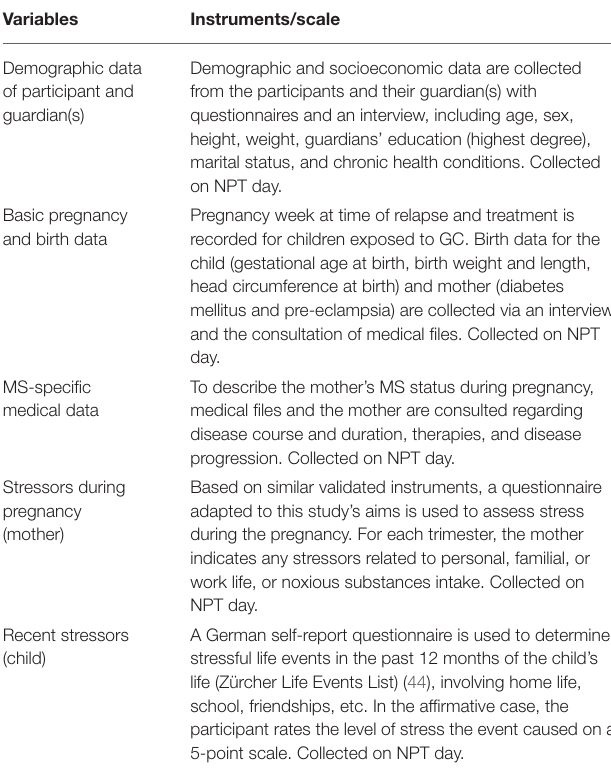
TABLE 1 | Basic clinical and demographic data